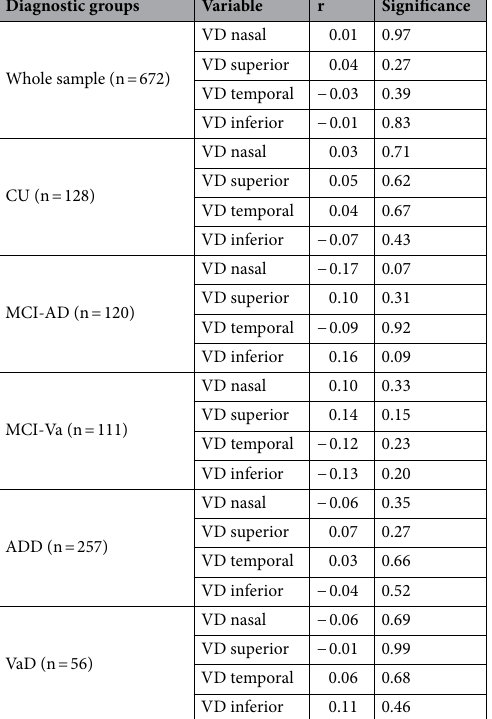
Table 4. Partial correlation of macular VD measurements with MMSE scores. The model included the following adjusting factors: age, sex, years of education, hypertension, diabetes mellitus and stroke. ADD = probable Alzheimer´s disease dementia; CU = cognitively unimpaired; MCI-AD = mild cognitive impairment due to Alzheimer´s disease; MCI-Va = mild cognitive impairment due to cerebrovascular pathology; VaD = vascular dementia; VD = vessel density. Significance was set up at p <